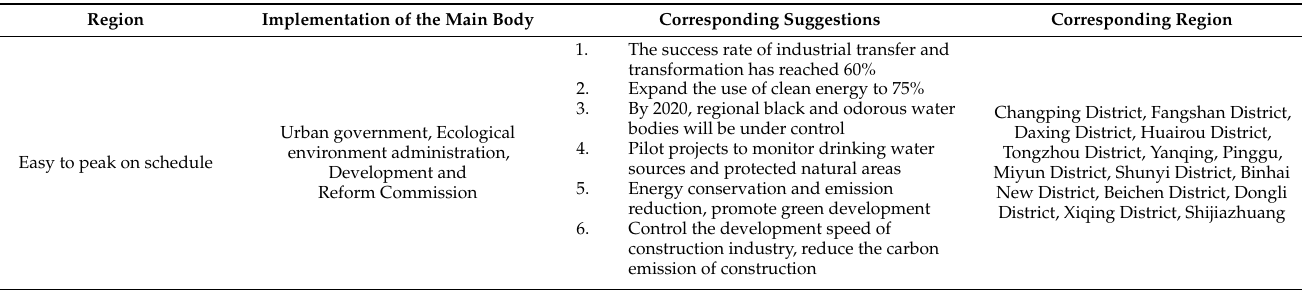
Table 4. Recommendations for areas that are easy to peak carbon on time.